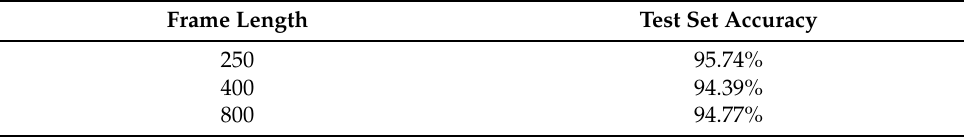
Table 2. Effects of frame length on model